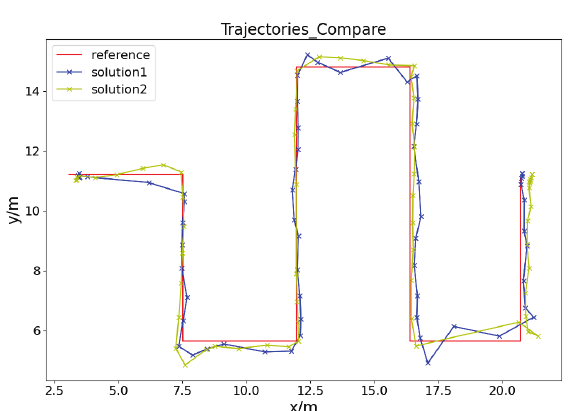
Figure 7 . Comparison of the reference trajectory and the trajectory obtained by the two base station arrangements of ‘solution 1’ and ‘solution 2’.